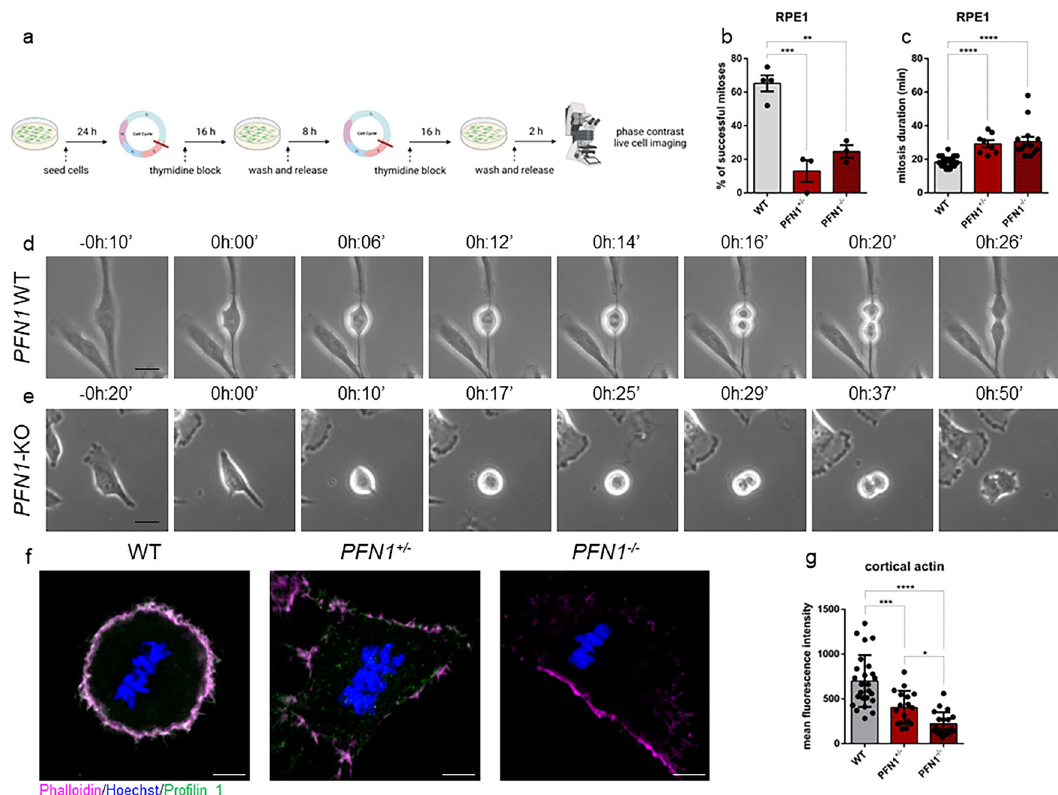
Fig. 3 Pro fi lin 1 knock-out induces prolonged mitosis. a Schematic of the experiment created in BioRender (https://biorender.com/) by F.S.d.C. as a registered user. b Percentage of cells able to complete mitosis following the round up; data are shown as mean ± s.e.m.; dots represent the mean for each experiment ( n = 67 WT, 44 PFN1 + / − , 43 PFN1 − / − RPE1 cells; range of number of cells used for each individual experiment: 9-25 WT, 13-16 PFN1 + / − , 11-16 PFN1 − / − ); *** P = 0.0005, ** P = 0.0023. The mean difference between PFN1 + / − and PFN1 − / − cells was not statistically signi fi cant ( P = 0.4310). c Time taken from start (cell rounding) to end (cytokinesis) of mitosis; data are shown as mean ± s.e.m.; dots represent the duration of each cell division expressed in minutes ( n mitoses = 39 WT, 8 PFN1 + / − , 14 PFN1 − / − RPE1 cells); **** P < 0.0001. Data in b and c were analysed by ordinary one-way ANOVA. d Representative time-lapse phase-contrast images (taken every 2 min) of WT and e PFN1 -KO RPE1 cells; scale bars 25 μ m. Time stamps indicate elapsed time in hours:minutes. f WT, PFN1 + / − and PFN1 − / − RPE1 cells at metaphase stained for DNA (Hoechst 33342, blue), Pro fi lin 1 (green) and F-actin (phalloidin, magenta); scale bars 5 μ m. g Mean fl uorescence intensity of cortical actin; data are shown as mean ± s.e.m.; dots represent the fl uorescent intensity for each sample ( n = 25 for WT, 17 for PFN1 + / − , 20 for PFN1 − / − cells); *** P = 0.0002, **** P < 0.0001, * P = 0.0436. Ordinary one-way ANOVA